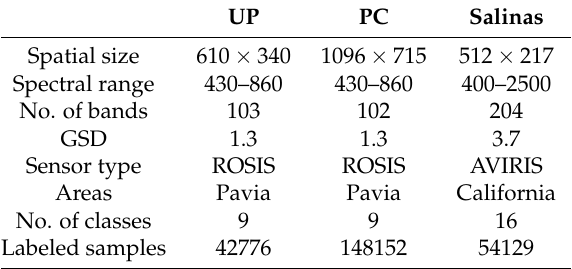
Table 3. Details of three target data sets. University of Pavia (UP), Pavia Center (PC), ground sample spectrometer (ROSIS), airborne visible infrared imaging spectrometer (AVIRIS).